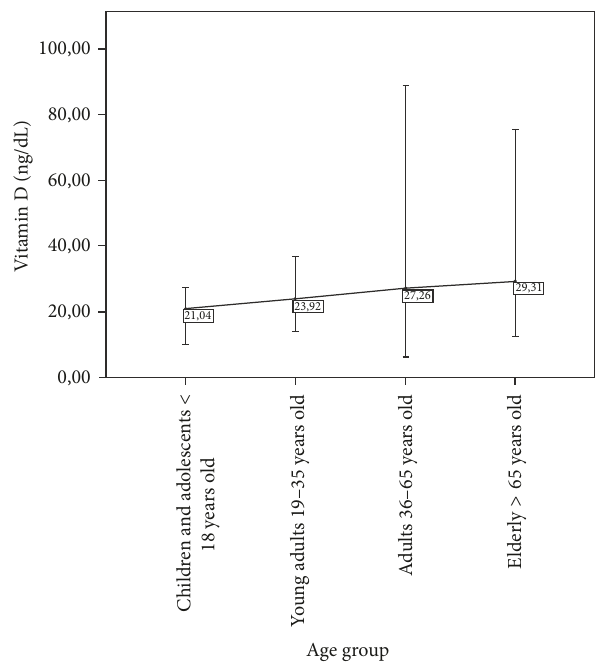
Figure 3: Mean 25 (OH)-D levels in the age groups.